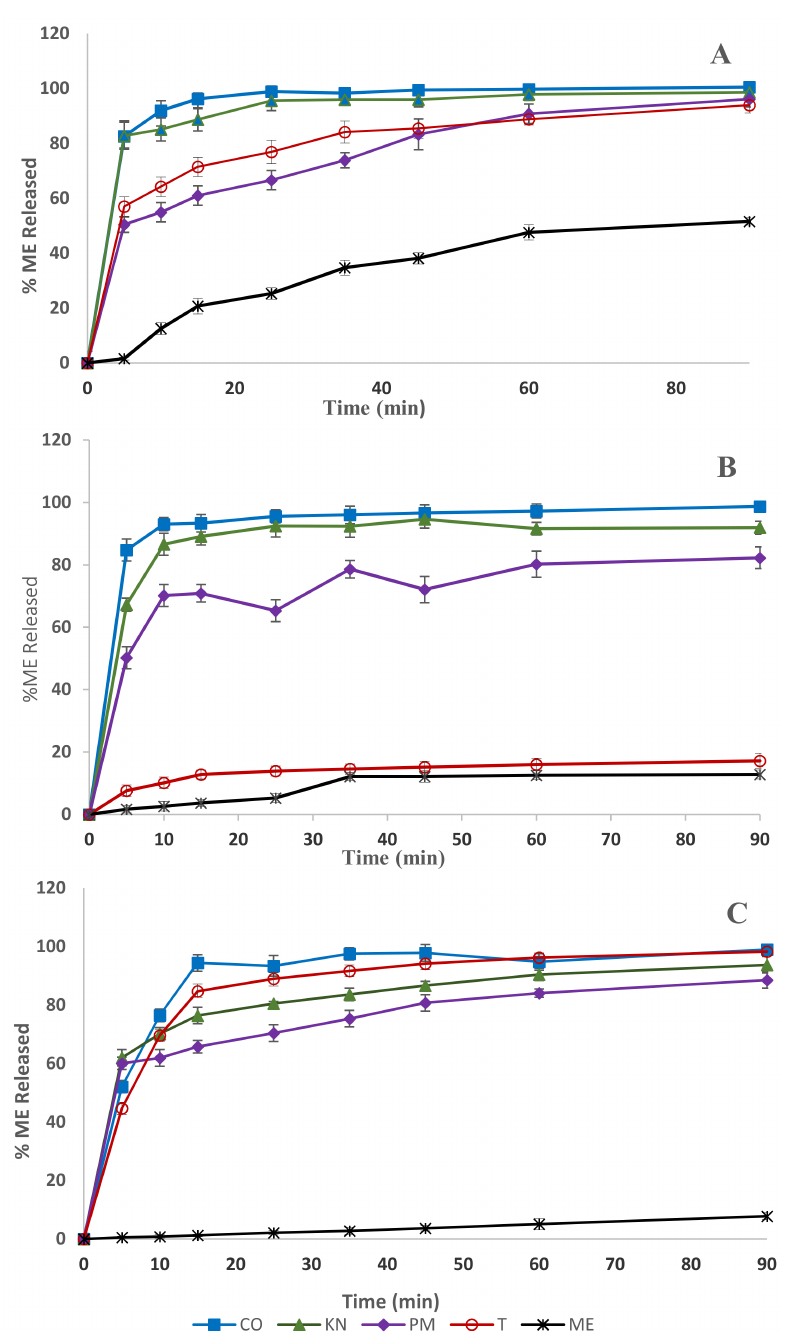
Figure 6. In vitro dissolution performance of ME from different prepared systems; coevaporate (CO), kneaded (KN), physical mixture (PM), commercial ME (T), and ME untreated powder (ME); in ( A ) Phosphate buffer pH 7.4; ( B ) pH 1.2; and ( C ) distilled water; Key: Co (filled square), KN (filled triangle), PM (filled diamond), T (empty circle) and ME (stare); n =